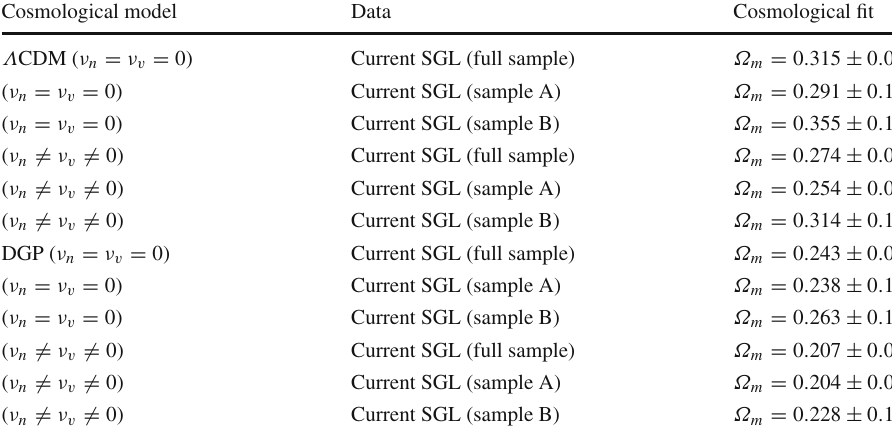
Fig. 2 Constraints on the matter density parameter in the flat Λ CDM model, which are obtained from the lens redshift distribution of current SGLsystemswithandwithouttheredshiftevolutionoflensinggalaxies.